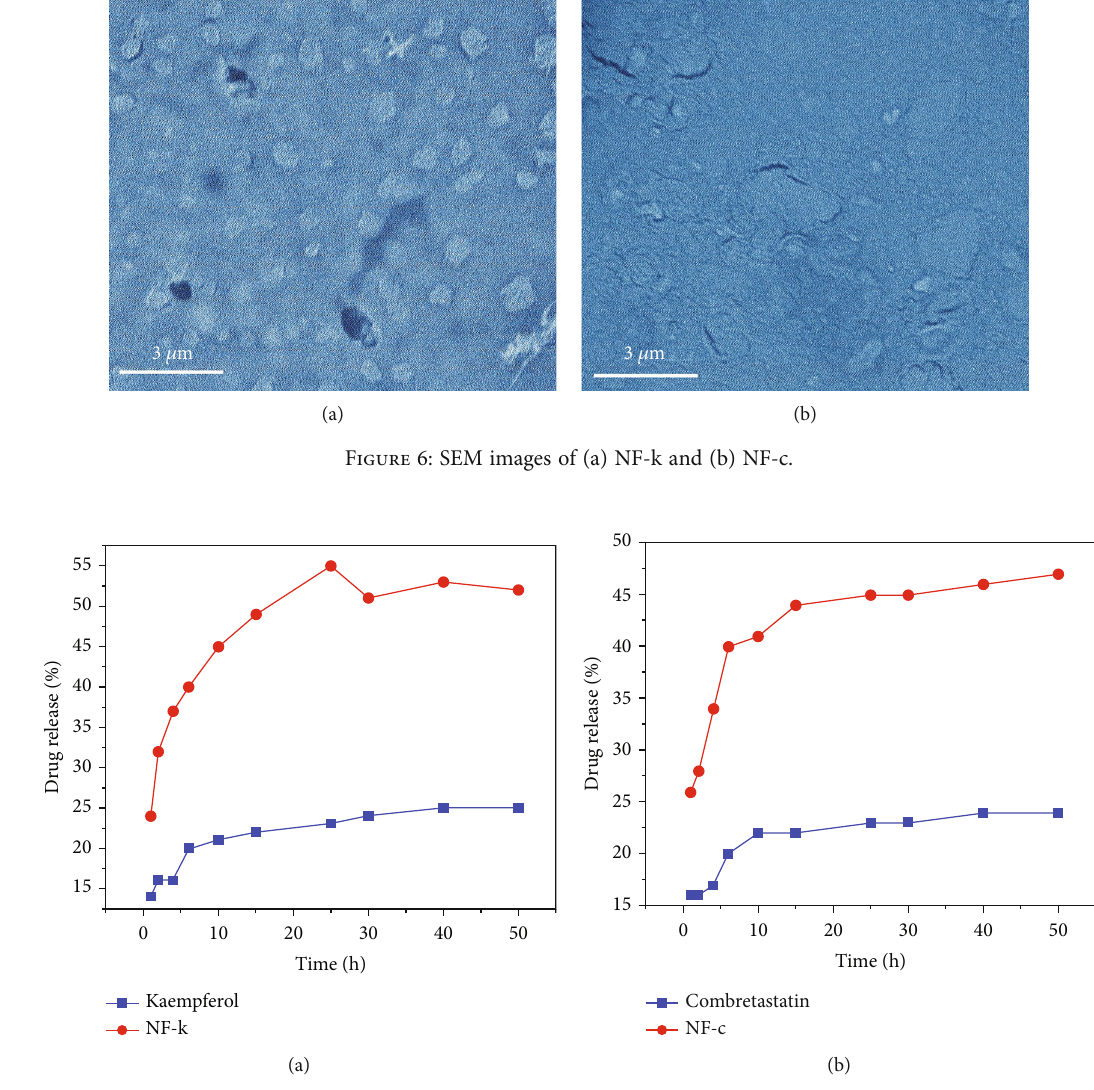
Figure 7: Drug release kinetics of (a) NF-k and kaempferol and (b) NF-c and